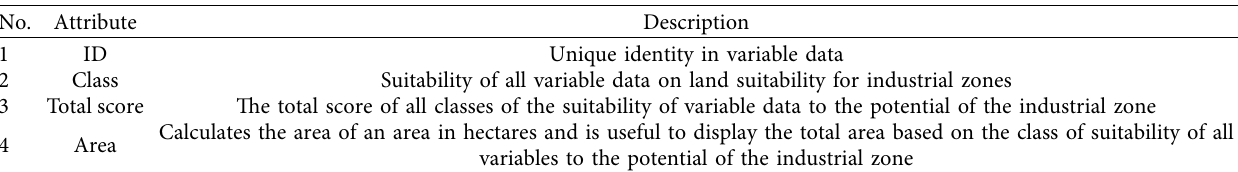
Table 2: Variable data conformity industrial